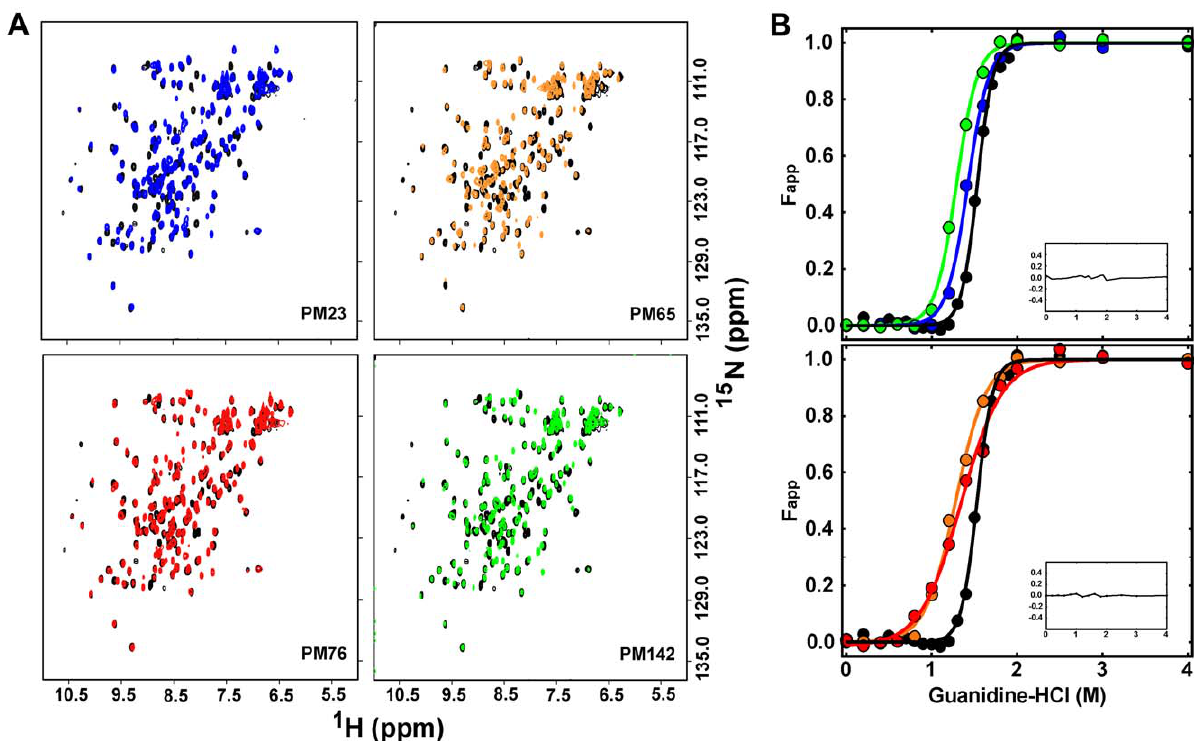
Figure 2. Plots of the (A) 1 H- 15 N-HSQC spectra and (B) equilibrium titration of F app as a function of denaturant concentration for WT-IL-1 b and permutant proteins. (A) Representative spectra used to determine the effects of permutation on the global fold of the protein. Each permutant variant spectrum is overlaid with a spectrum of WT IL-1 b (black). (Top, left) The spectrum of PM23 in overlaid blue. (Top, right) The spectrum of PM65 overlaid in orange. (Bottom, left) The spectrum of PM76 overlaid in red. (Bottom, right) The spectrum of PM142 overlaid in green. The overall pattern remains unaffected by circular permutation. (B) Following the same coloring scheme as above, equilibrium denaturation curves for WT IL-1 b and circular permutant variants were plotted as F app versus denaturation concentration. (Top) An overlay of WT-IL-1 b plotted with PM23 and PM142. (Bottom). An overlay of WT IL-1 b plotted with PM65 and PM76. Continuous lines represent the best-fit curves that are fit to a two-state model and are shown in the same color scheme. The residuals of the fit are shown as the inset.